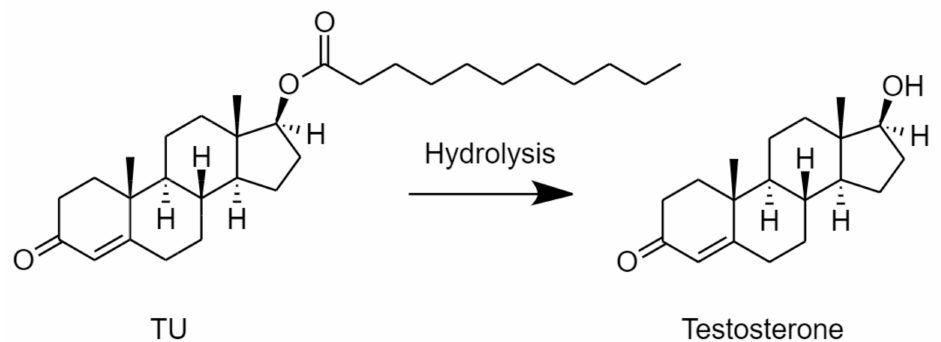
Figure 1. Hydrolysis of testosterone undecanoate (TU) to